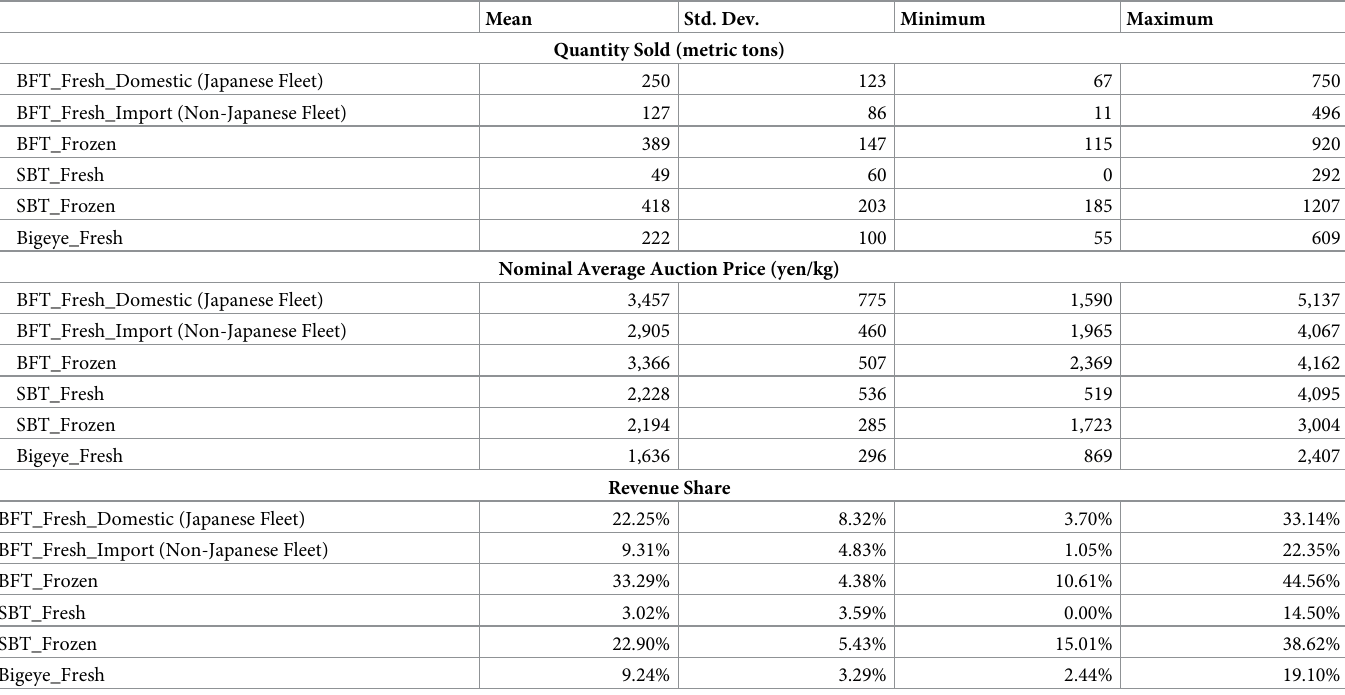
Table 1. Monthly sample statistics of tuna auction market in Tokyo,